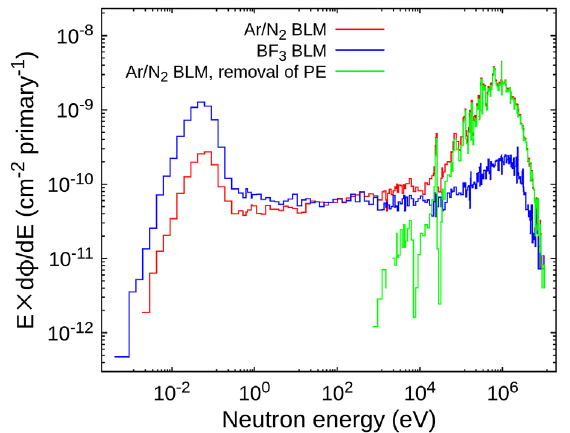
FIG. 26. Simulated spectra of neutrons entering into the two